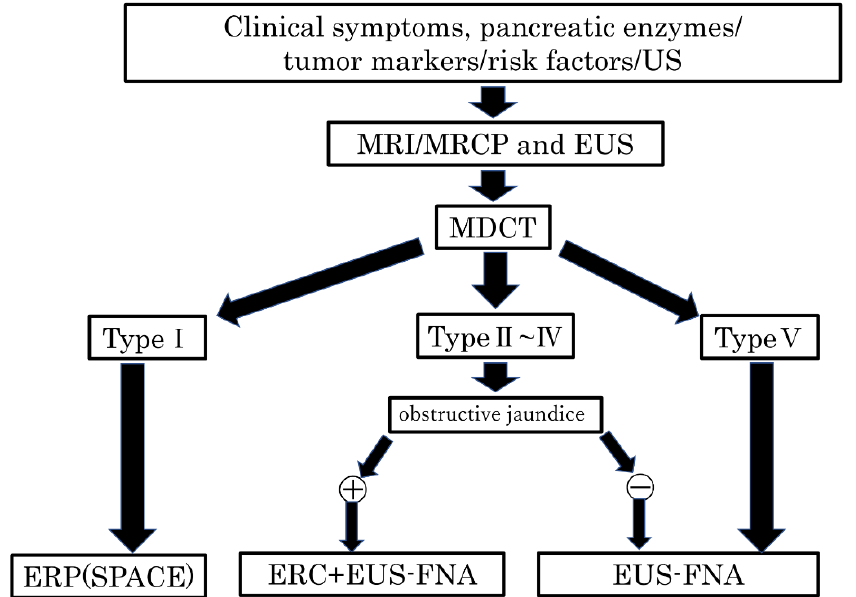
Figure 9. Algorithm of the diagnostic management of PDAC without the MPD dilatation. US, ultrasonography; MRI, magnetic resonance imaging; MRCP, magnetic resonance cholangiopancreatography; EUS, endoscopic ultrasonography; MDCT, multidetector raw CT; ERP, endoscopic retrograde pancreatography; SPACE, serial pancreatic juice aspiration cytologic examination; ERC, endoscopic retrograde cholangiography; EUS-FNA, endoscopic ultrasonography-guided fine needle aspiration; MPD, main pancreatic duct; PDAC, pancreatic ductal adenocarcinoma.